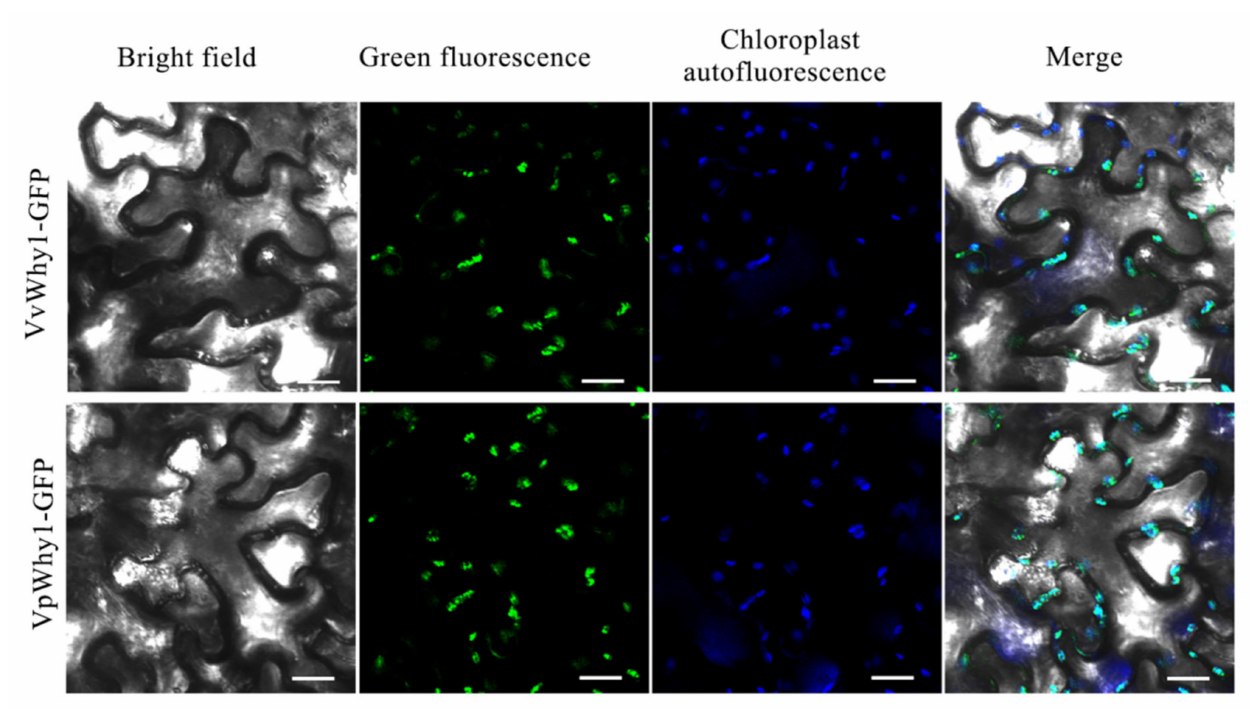
Figure 4. Subcellular localization of VvWhy1 and VpWhy1. N. benthamiana leaves were used to express Why1-GFP fusion protein. Fluorescence observation was conducted using an FV1000 confocal laser-scanning microscope (Olympus, Tokyo, Japan). The green signal indicates GFP fluorescence, the blue signal indicates chloroplast autofluorescence and the cyan signal indicates merge result. Both Why1 proteins were chloroplast-localized. Scale bar = 20 µ